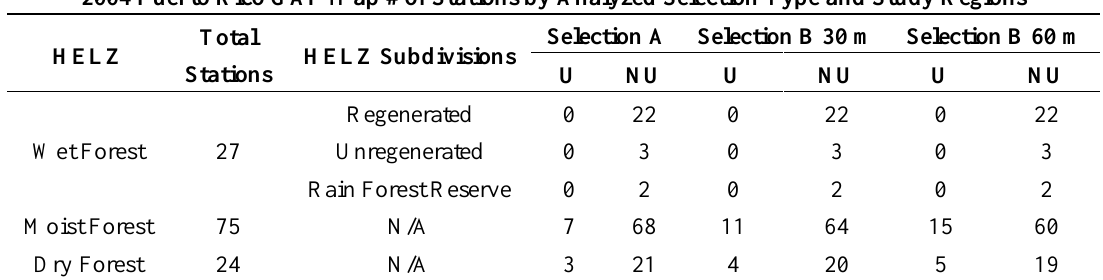
Table 4. Number of stations by Selection Type and Analyzed HELZ and Land Cover for the 2004 Puerto Rico Gap